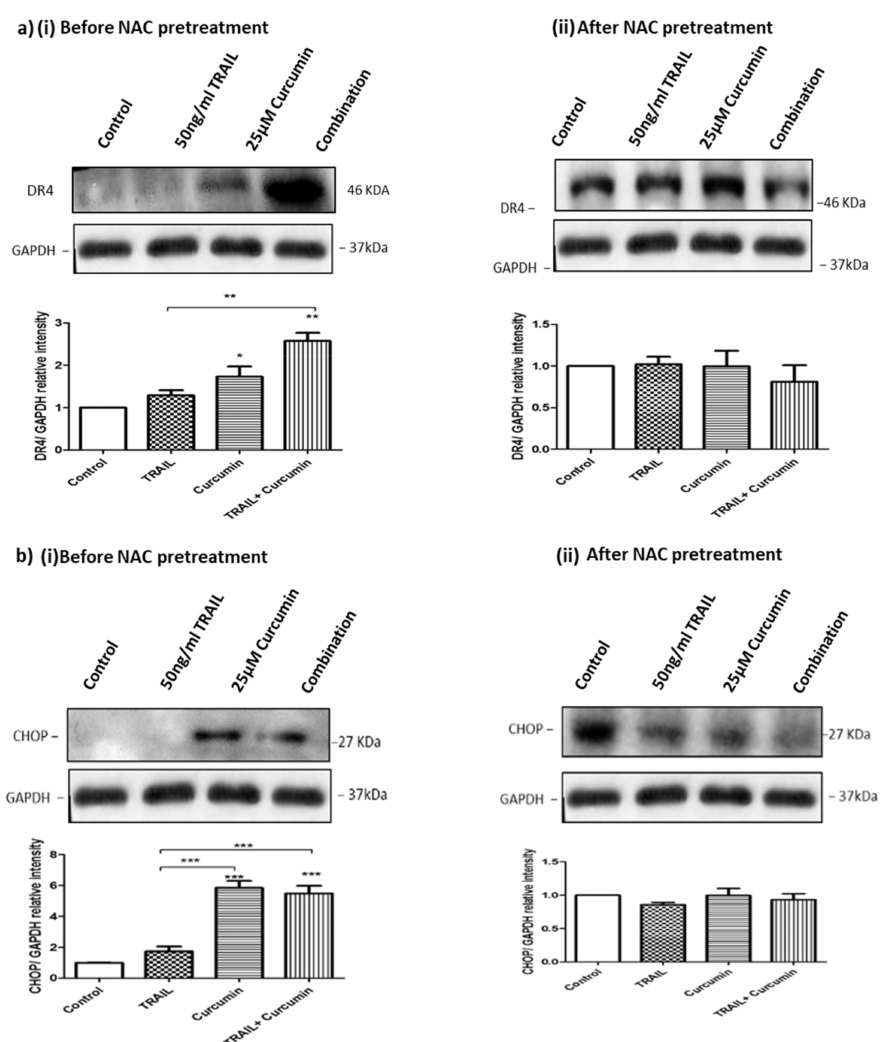
Figure 10. NAC pre-treatment abrogates CHOP and DR4 activation by curcumin or curcumin / TRAIL combination. ACHN cells were pre-treated with 0.5% DMSO-containing culture medium, 50 ng / mL TRAIL, 25 µ M curcumin or a co-treatment of 50 ng / mL TRAIL + 25 µ M curcumin. The cells were pre-treated with 10 mM N-acetyl cysteine (NAC) for 1 h to block ROS activity prior to exposure to the various treatments for 24 h. Whole cell protein was extracted at 24 h with RIPA bu ff er. Equal amounts of protein were separated by SDS-PAGE electrophoresis, transferred to nitrocellulose and indirectly probed for ( a ) DR4 and ( b ) CHOP using monoclonal antibodies and an ECL detection system. GAPDH was used as a loading control. *, ** and *** indicate statistically significant di ff erences from respective controls at p < 0.05, p < 0.01 and p < 0.01. One-way ANOVA was used to analyse the